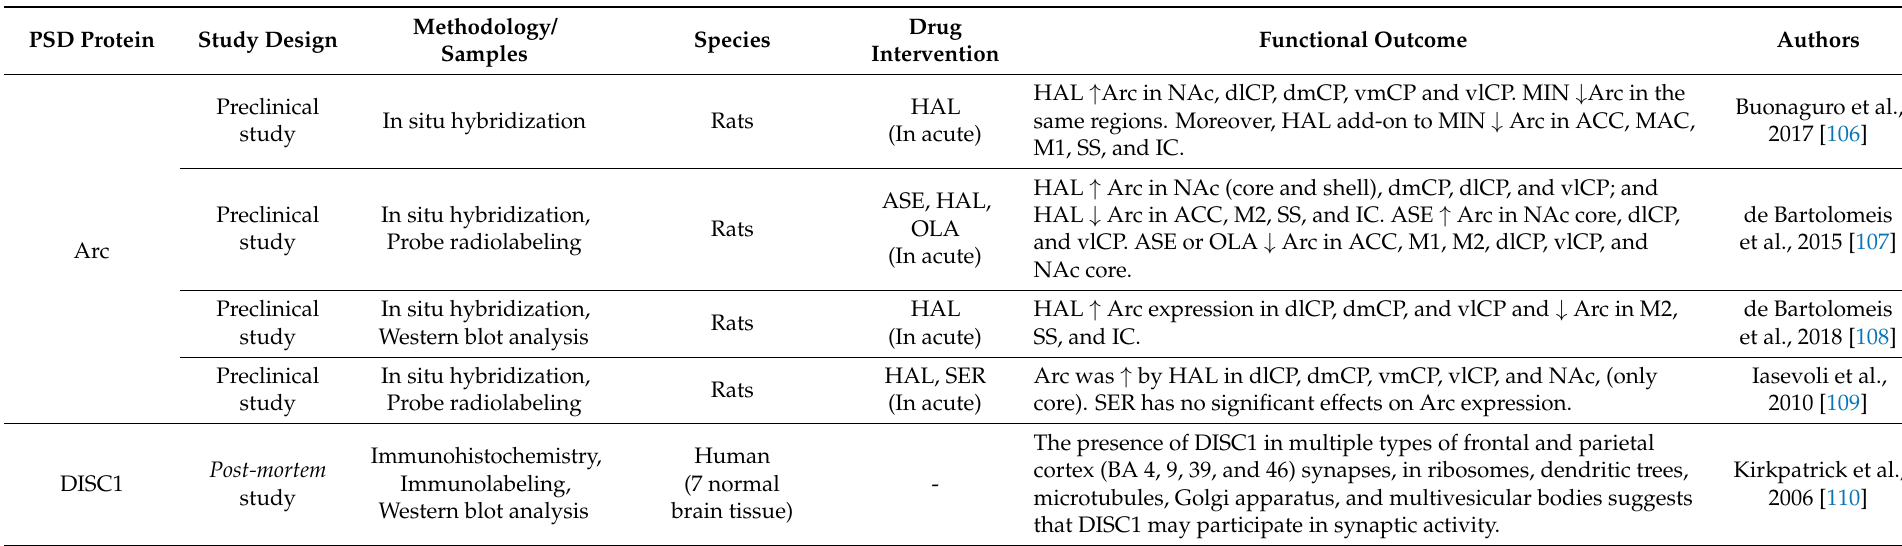
Table 2. PSD proteins expression after drug administration in preclinical or post-mortem study. Arc = activity-regulated cytoskeleton-associated protein; ASE = asenapine; OLA = olanzapine; HAL = haloperidol; MIN = minocycline; SER = sertindole; KET = ketamine; AMS = amisulpride; ACC: anterior cingulate cortex; MAC = medial agranular cortex; SS = somatosensory cortex; IC = insular cortex; NAc = nucleus accumbens; M1 = motor cortex; M2 = medial agranular cortex; dlCP = dorsolateral caudate–putamen; dmCP = dorsomedial caudate-putamen; vmCP = ventromedial caudate-putamen; vlCP = ventrolateral caudate–putamen; DISC1 = disrupted-in-schizophrenia 1; NLGN = neuroligin; SHANK = SH3 and multiple ankyrin repeat domains; PSD = postsynaptic density; DLGAP = disks large-associated protein; VPA = valproate; AT = antipsychotic; PFC = prefrontal cortex; PrL = prelimbic cortex; VO = ventral orbital cortex; LO = lateral orbital cortex; DLO = dorsolateral orbital cortex; Ddo − / − = D-aspartate-oxidase knockout mice; DAT = dopamine transporter; VTA = ventro-tegmental area; SNc = substantia nigra pars compacta; SCZ = schizophrenia; CAMKII = calcium/calmodulin-dependent protein kinase II; TER = terguride; CLO = clozapine; ZIP = ziprasidone; MEM = memantine; NRG = neuregulin; ErbB4 = Erb-B2 Receptor Tyrosine Kinase 4; ↓ = decrease; ↑ = increase; PN = postnatal days; PCP = phencyclidine;; p- ErbB4 = phosphorylated-Erb-B2 receptor tyrosine kinase 4; DLG = discs large MAGUK scaffold protein; NMDA = N-methyl-D-aspartate; pS295 = A phosphorylated state of PSD-95; JNK = Jun N-terminal kinase; DLPFC = dorsolateral prefrontal cortex; Cdk5 = cyclin dependent kinase 5; Rack1 = receptor for activated C kinase 1; NR2 = human NMDA receptor 2; KD = knockdown; SNP = single nucleotide polymorphism; ASD = autism spectrum disorder; MDD = major depressive disorder; VGLUT1 = presynaptic vesicular glutamate transporter 1; APZ = aripiprazole; LTP = long-term potentiation; Akt = serine/threonine kinase family; GSK3 = glycogen synthase kinase-3; PCC = posterior cingulate cortex; BD = bipolar disorder; NF-L = neurofilament light chain protein; DG = dentate gyrus; Sub = subiculum; PDZ = postsynaptic density-95/discs large/zone occludens-1; PMDS = Phelan–McDermid Syndrome; CME = clathrin-mediated endocytosis; qRT-PCR = real-time quantitative reverse transcription polymerase chain reaction; ECL = chemiluminescence; BDNF = brain-derived neurotrophic